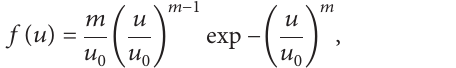
categories. Figure 1(e) is the meso-structure characterization image obtained after CTslice processing with DIPS software.